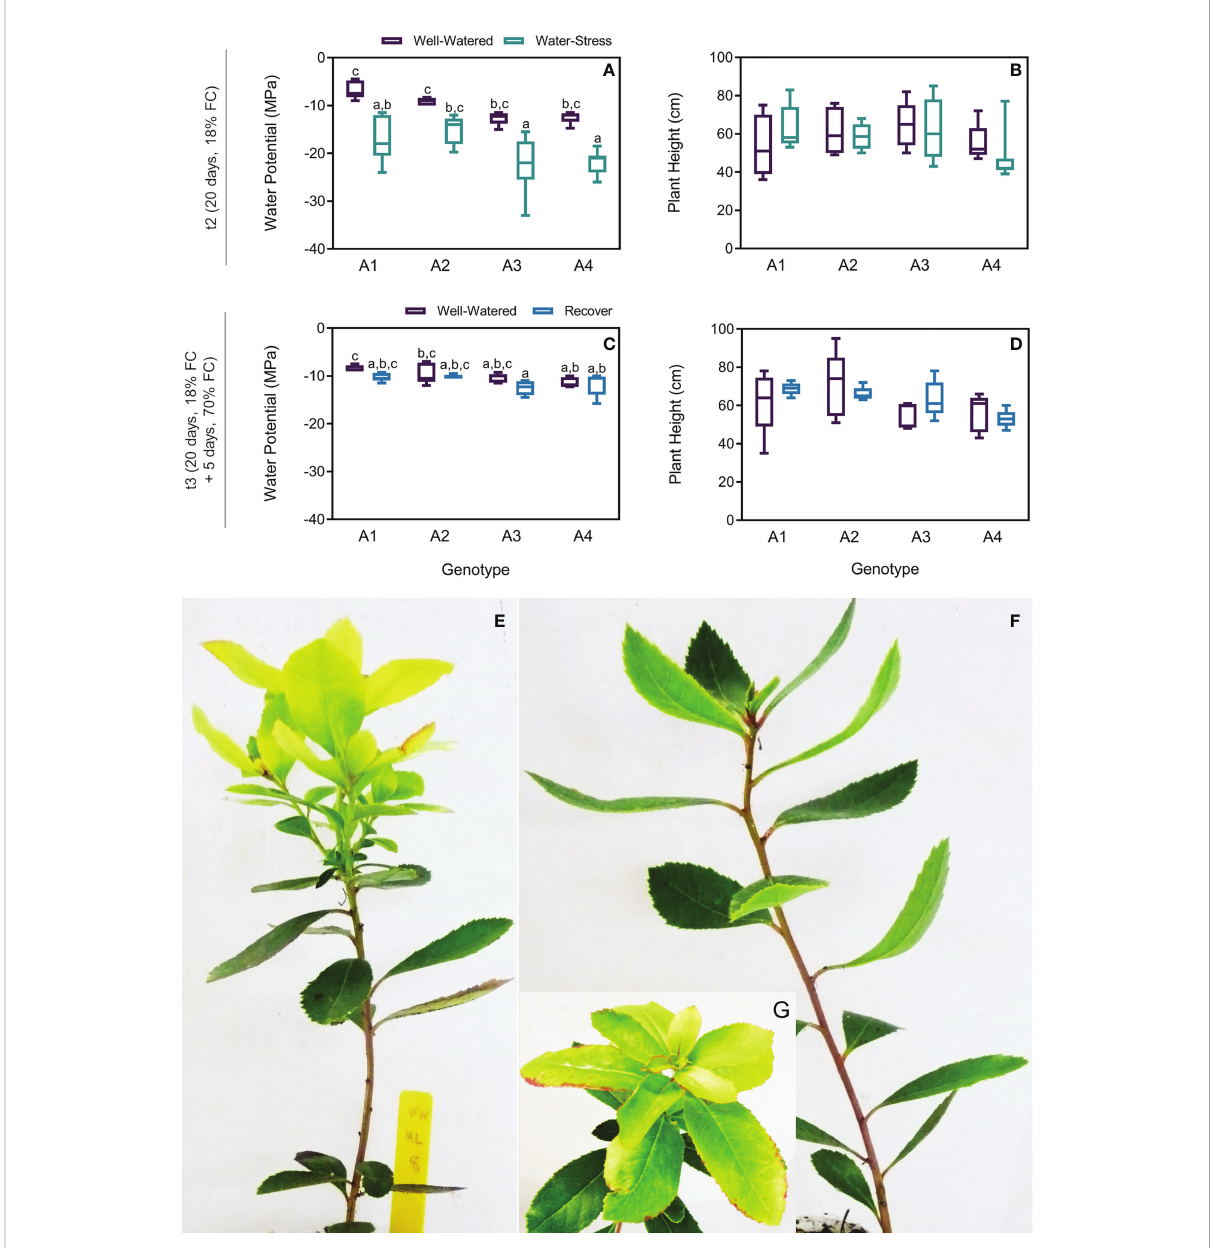
FIGURE 2 Water potential and plant height on t2 (20 days) and t3 (20 + 5 days) on 4 genotypes (A1, A2, A3 and A4) and 3 water regimes (well-watered, water-stress and recover) and morphological changes under drought: water potential on t2 (A) , plant height on t2 (B) , water potential on t3 (C) , plant height on t3 (D) , strawberry tree plant from genotype A1 under well-watered (WW) (E) and water-stress (WS) conditions (F, G) . Means ± SDs, n = 5-7, different letters indicate signi fi cant differences between treatments at P ≤ 0.05 according to a Tukey ’ s multi comparison